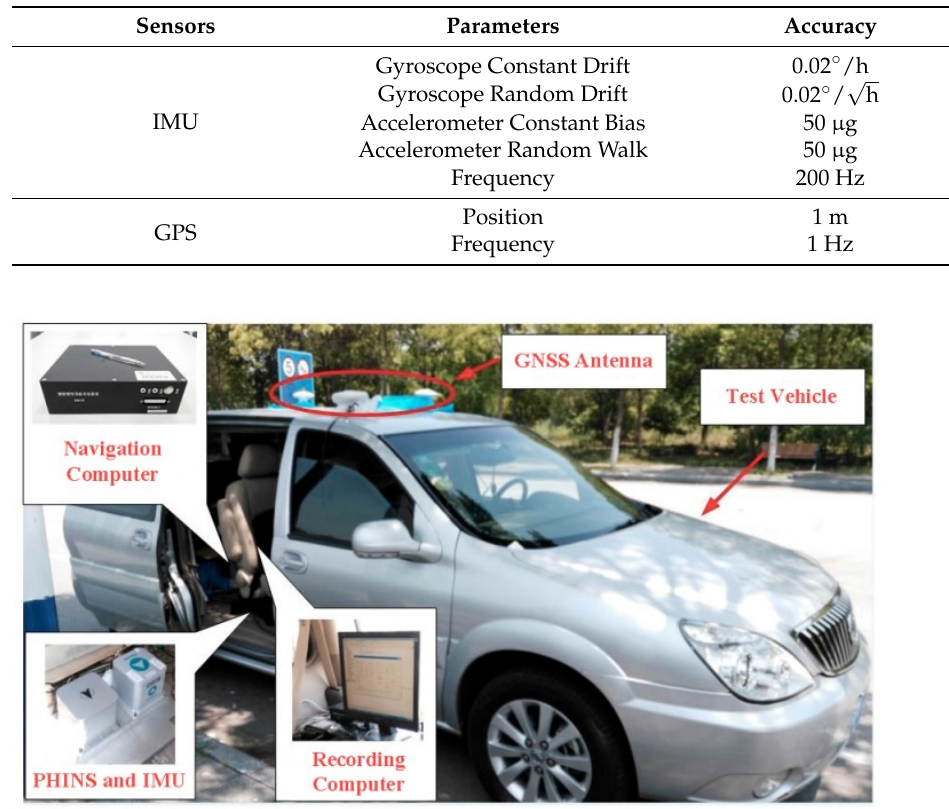
Figure 2. Installation diagram for vehicle-mounted experiment. Table 1. Specific of IMU and GPS parameters.